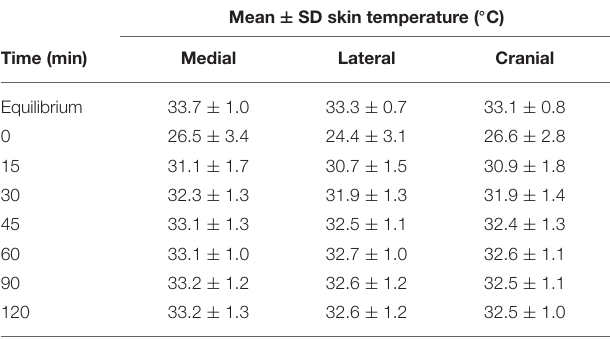
TABLE 1 | Mean ± SD skin temperature ( ◦ C) of each view at different times after cryotherapy